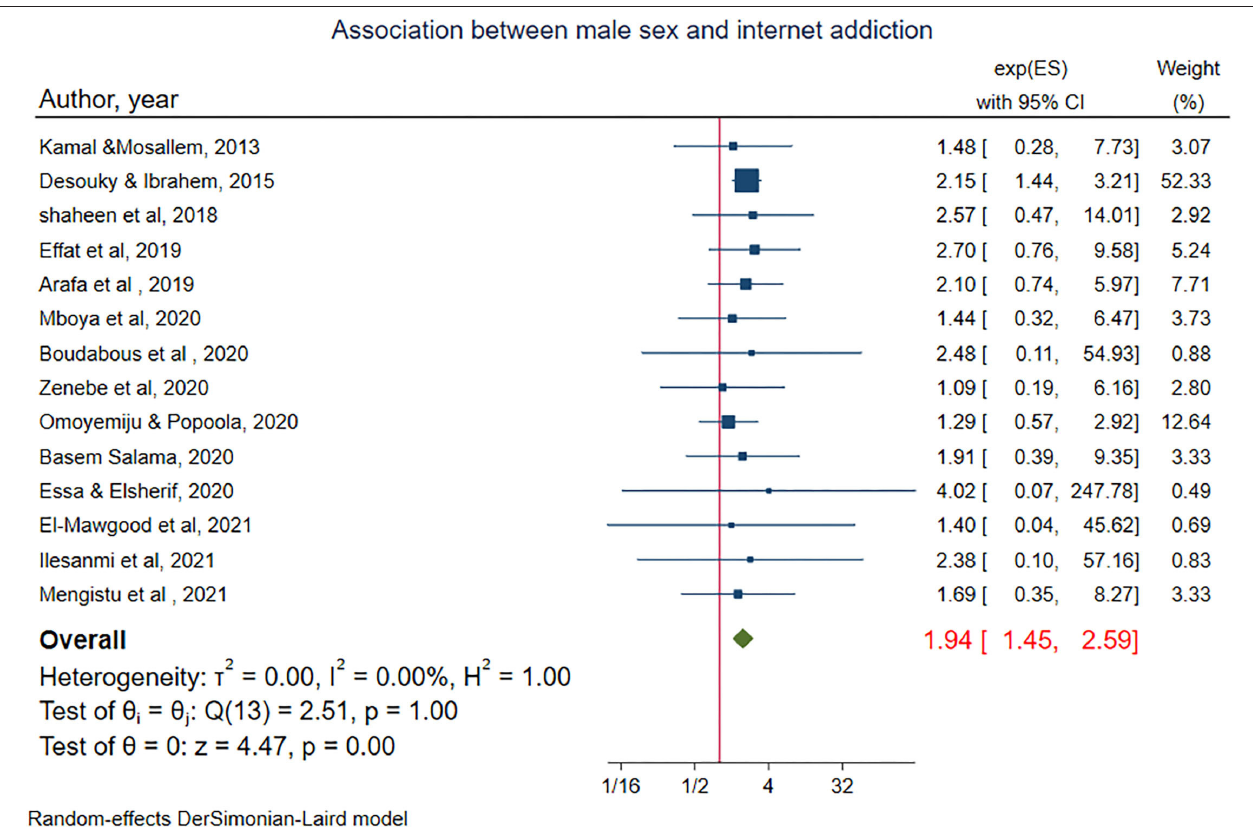
FIGURE 3 | The pooled association between sex and internet